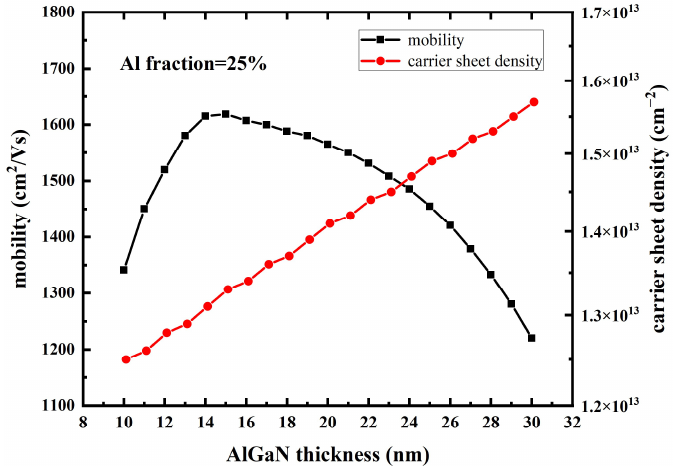
Figure 2. The mobility and carrier sheet density of device as AlGaN thickness variation.